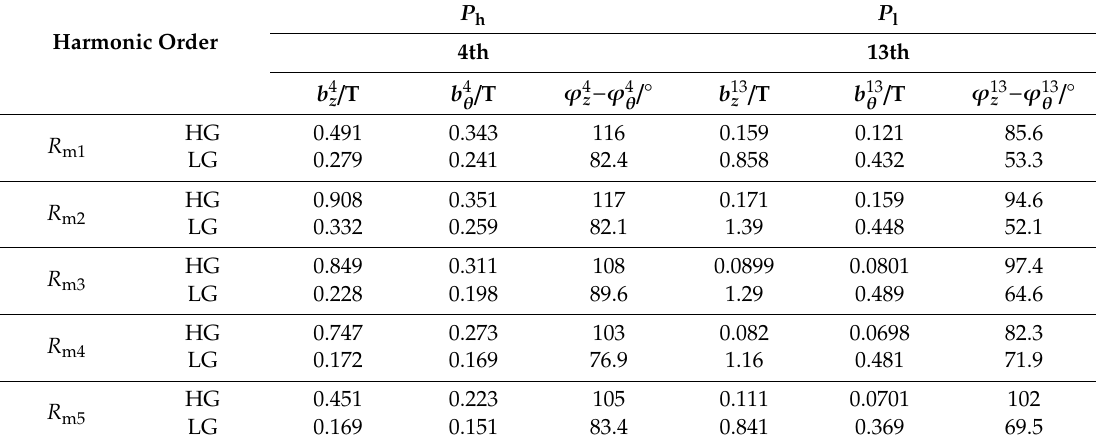
Table 3. Axial and tangential flux densities at the radii of R m1 , R m2 , R m3 , R m4 and R m5 in the HAMG and their phase di ff erences.